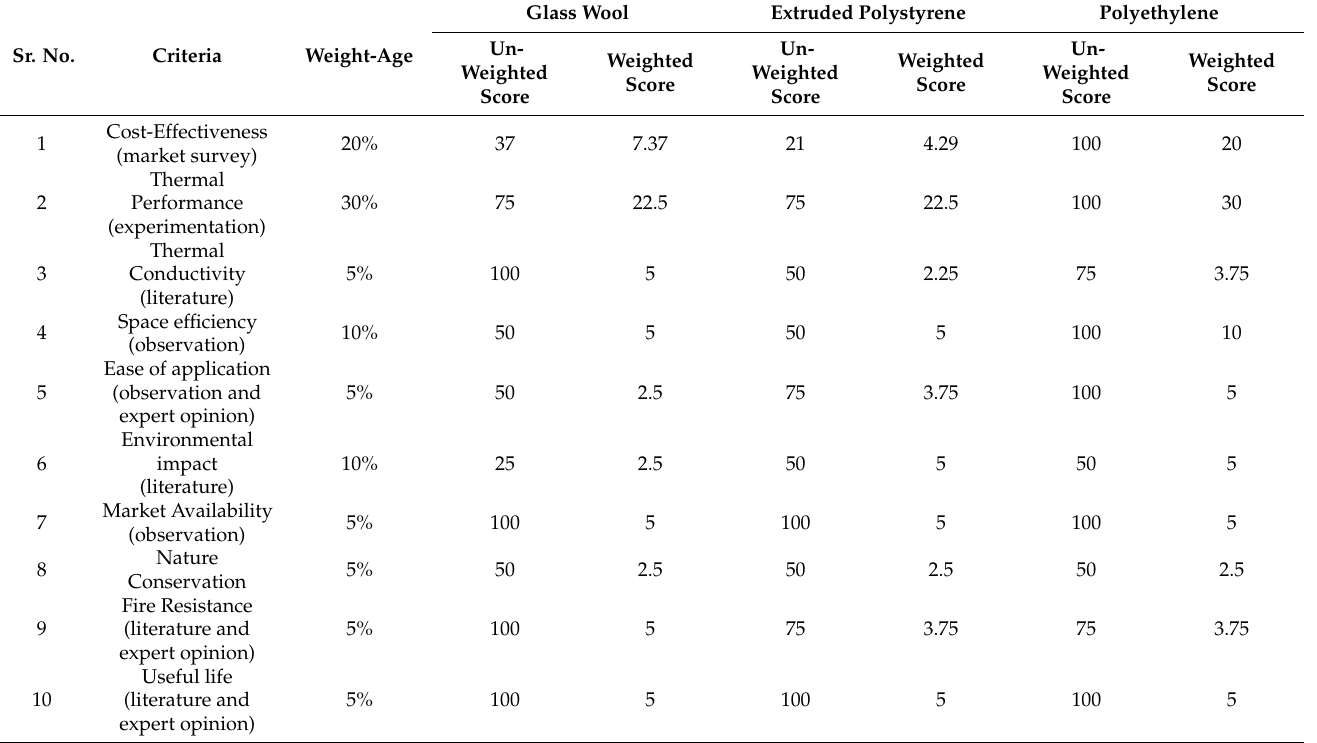
Table 6. Weighted score card for glass wool, extruded polystyrene and polyethylene.